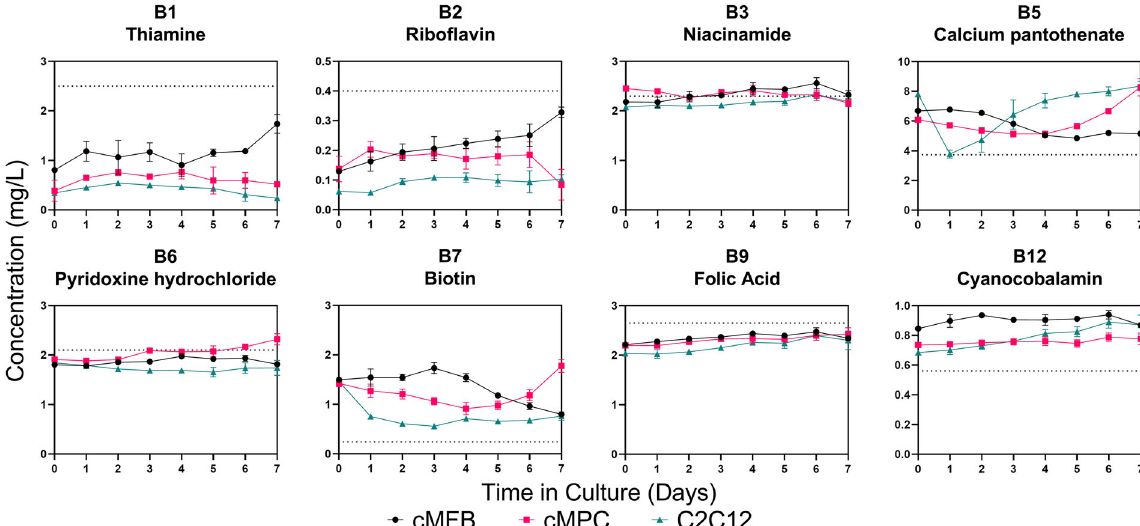
Fig. 3 Water-soluble vitamins. Analysis of B-vitamin concentrations in spent media from cultures of three cultivated meat-relevant cell types, using high performance liquid chromatography. Dotted lines represent expected concentrations of the vitamin based on the contributions from the basal media formulation consisting of 40% DMEM and 40% F10. Data points represent the mean of three biological replicates ± standard deviation. Note that the y -axis scales are not all the same. cMFB primary embryonic chicken muscle fi broblasts. cMPC primary embryonic chicken muscle precursor cells. C2C12 murine myoblast-like cell